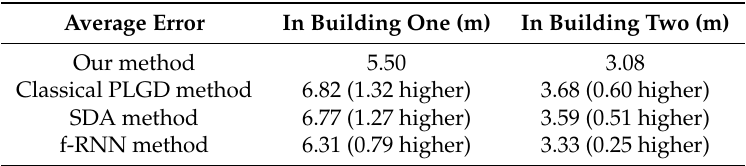
Figure 14. The CDF comparisons between the proposed method, the classical PLGD method, the SDA method and the f-RNN method in ( a ) Building One and ( b ) Building Two. Noting that here we enlarge the partial CDF for clarifying. Table 2. Average positioning error comparisons between the proposed method, the classical PLGD method, the SDA method and the f-RNN